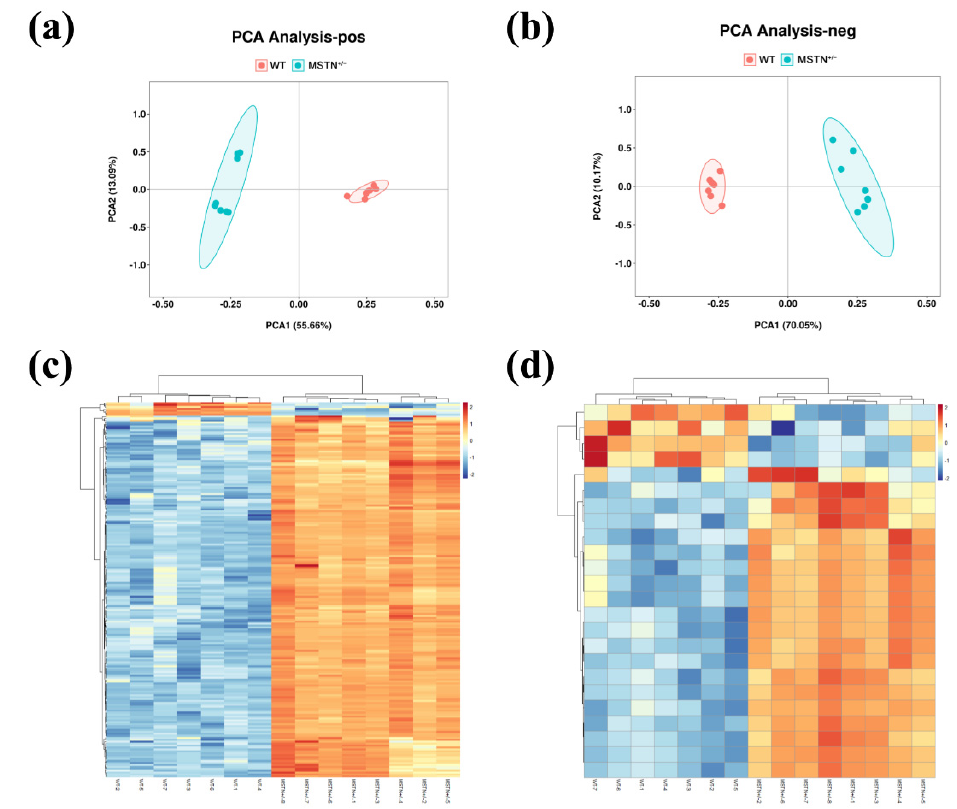
Figure 3. Untargeted metabolomics analysis of liver in MSTN +/ − and WT cattle. Principal component analysis (PCA) of metabolic data in positive ( a ) and negative ( b ) ion mode. Heat map of differential metabolites in positive ( c ) and negative ( d ) ion mode. WT, wild type; MSTN +/ − , MSTN heterozygous deletion. Table 2. Enrichment of metabolic pathways based on differentially expressed metabolites of liver in MSTN +/ − and WT cattle.